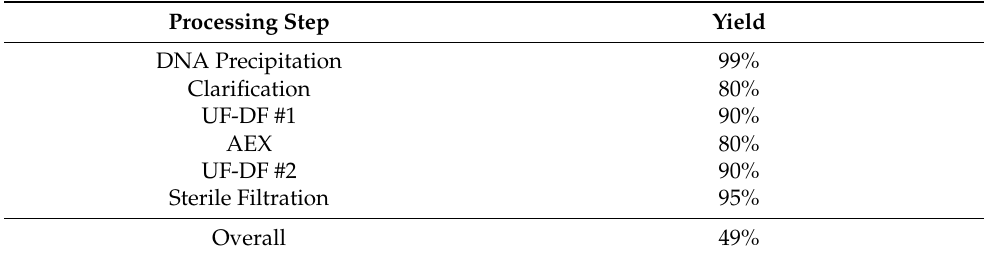
Table 8. Summary of downstream processing